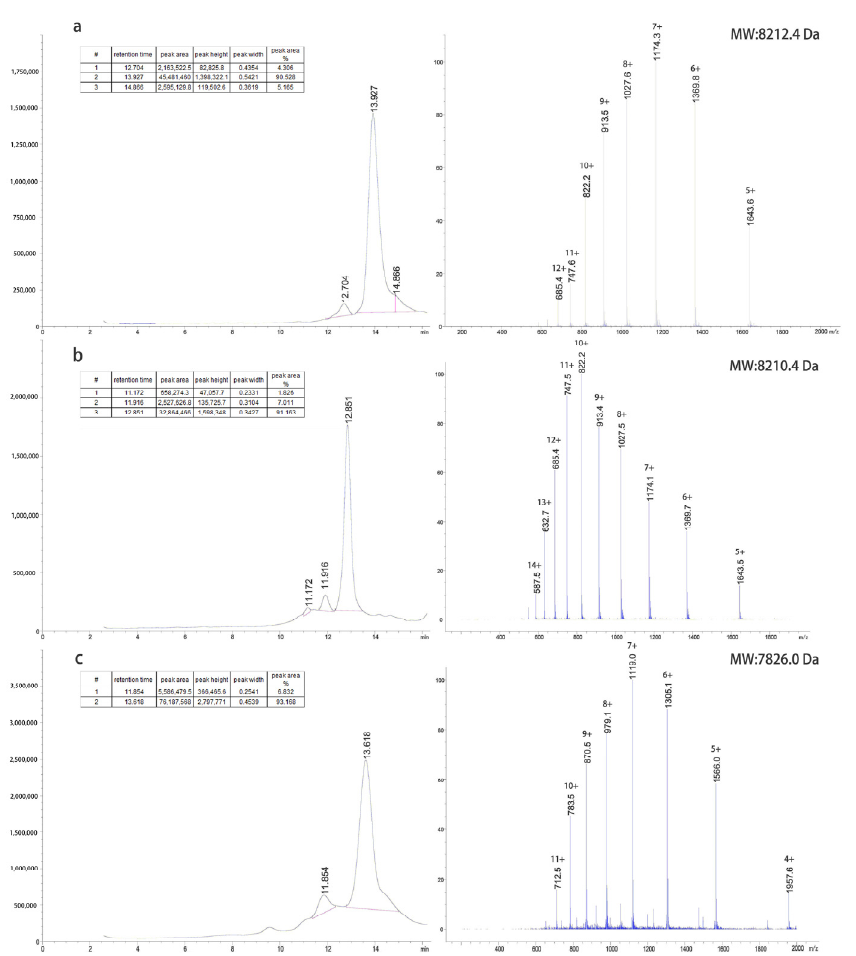
Figure 2. GLP-1RAs preparation. The refolding, digestion and purification processes were monitored by LC-MS, and the results of each GLP-1RAs obtained after purification were as follows: ( a ) G1 MW: 8212.4 Da; ( b ) G2 MW: 8210.4 Da; ( c ) G4 MW: 7826.0 Da.